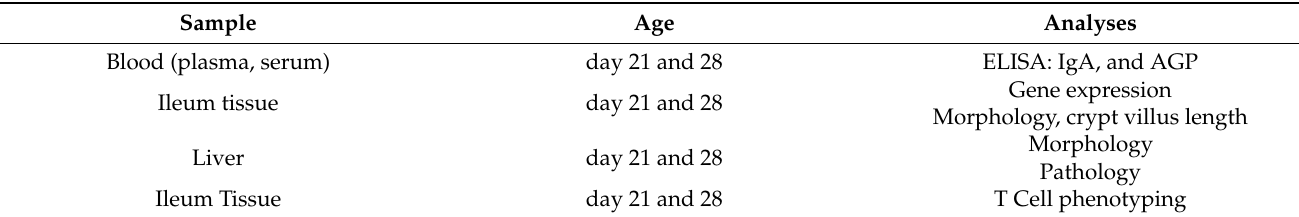
Table 2. Biological samples, bird age of collection, and analyses performed.